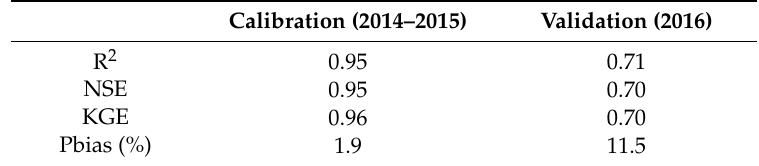
Table 6. Mebar model performance for the calibration and validation